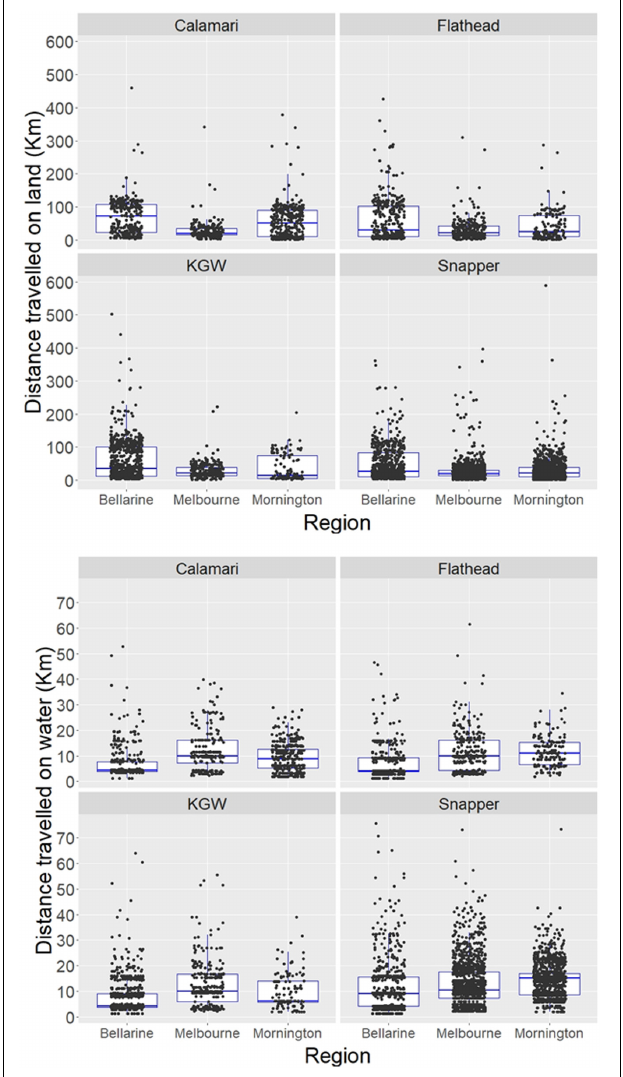
FIGURE 7 | Regional patterns (Bellarine, Melbourne and Mornington) in angler travel distance on land and water by individual key species in Port Phillip Bay combined across years. Each dot indicates an angler